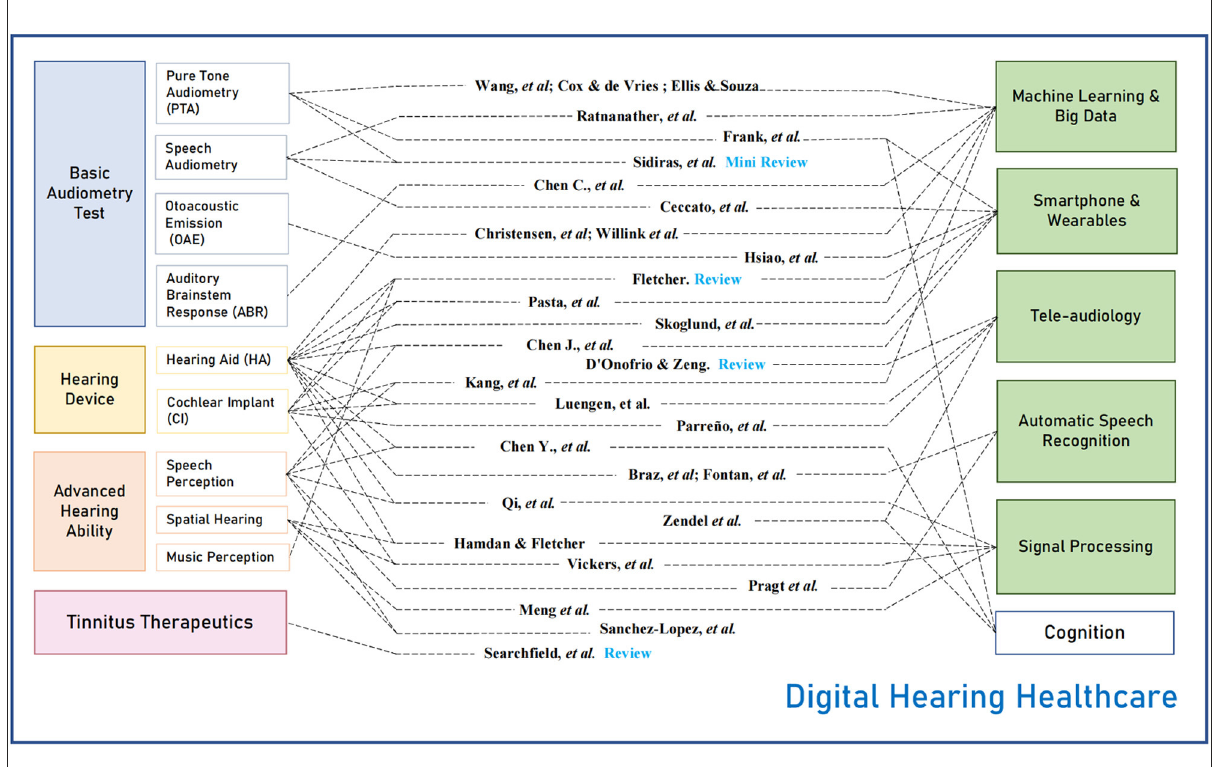
FIGURE1 Distribution of the 30 articles in this Digital Hearing Healthcare (DHH) Research